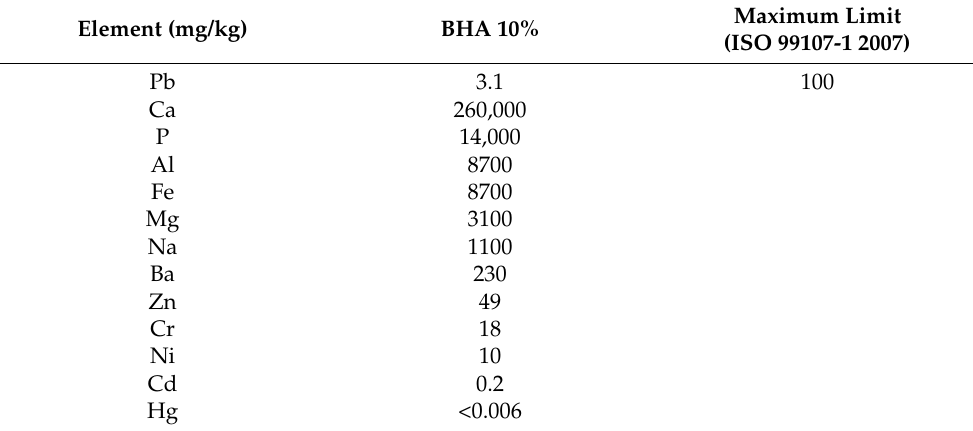
Table 2. Acid soluble content of BHA 10% cement determined by ICP-MS after 28 days immersion in H 2